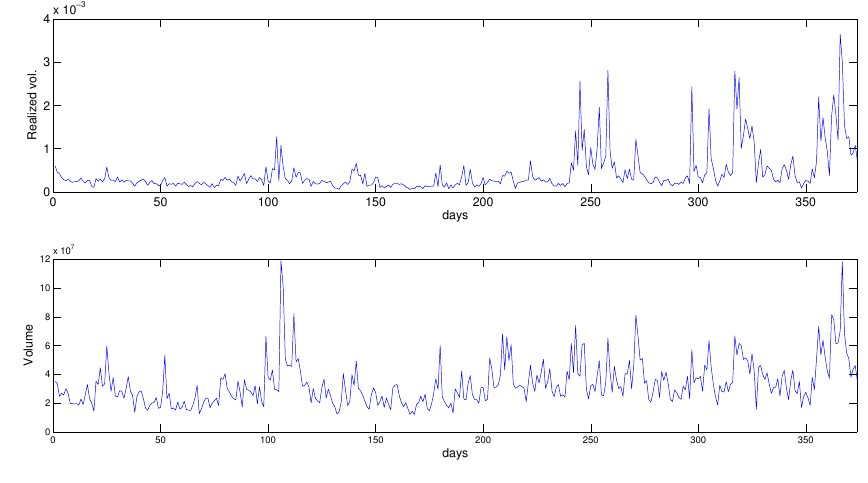
Figure 5: Estimated realized volatility (top panel) and volume of transactions (bottom panel).